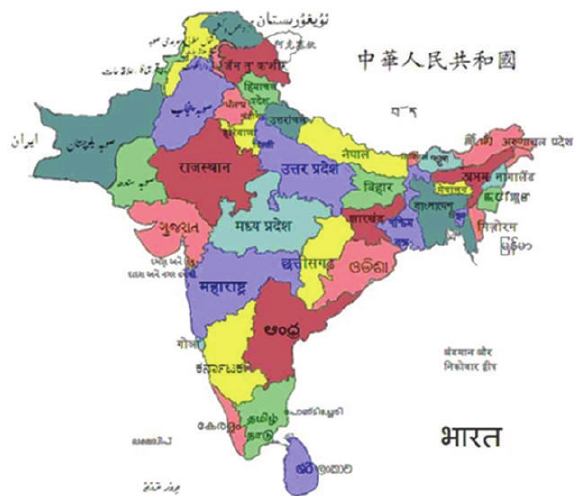
Figure 2: A map showing different languages and scripts for different states